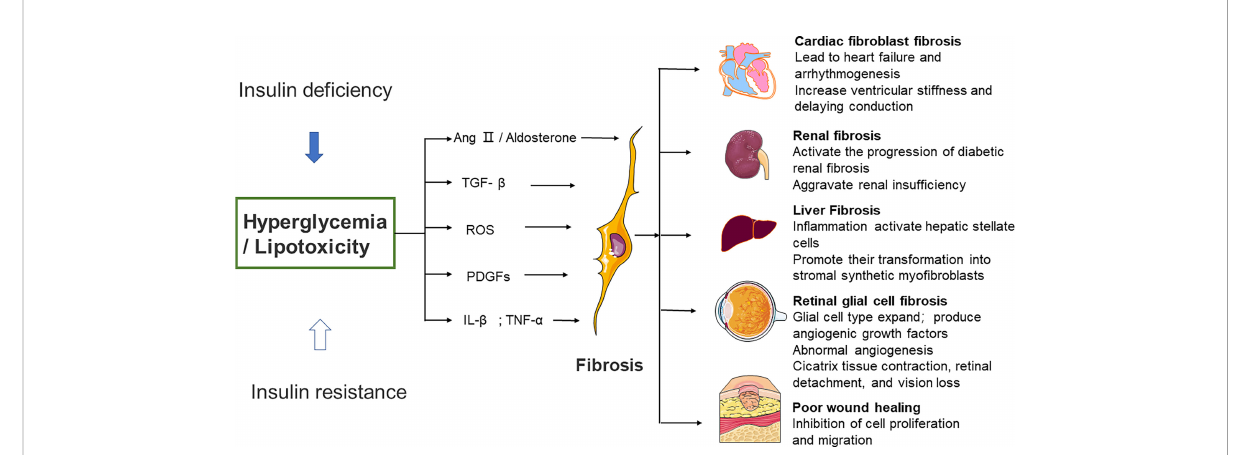
FIGURE 2 Effects of high glucose on fi broblast activity and fi brotic function of different organs. Several different mechanisms of diabetic fi brosis: 1) the activation of neurohumoral pathways, 2) induction and activation of growth factors such as TGF – b and platelet – derived growth factors, 3) stimulation of pro – in fl ammatory cytokines such as TNF – a and IL – 1 b . The main pathway that fi broblasts activate in response to high glucose involves ROS production, 4) high glucose can aggravate the damage of ROS to cells, promote cell senescence, and cause chronic in fl ammation and fi brosis. Ang II, angiotensin II, ROS, reactive oxygen species, PDGFs, platelet – derived growth factors, IL – b , interleukin – b , TNF – a , tumor necrosis factor a